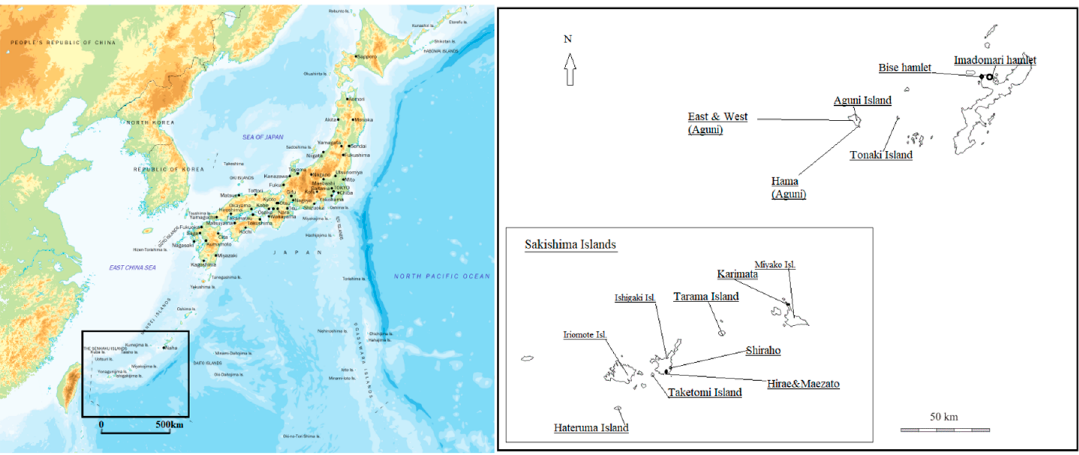
Figure 1. Locations of the survey sites.